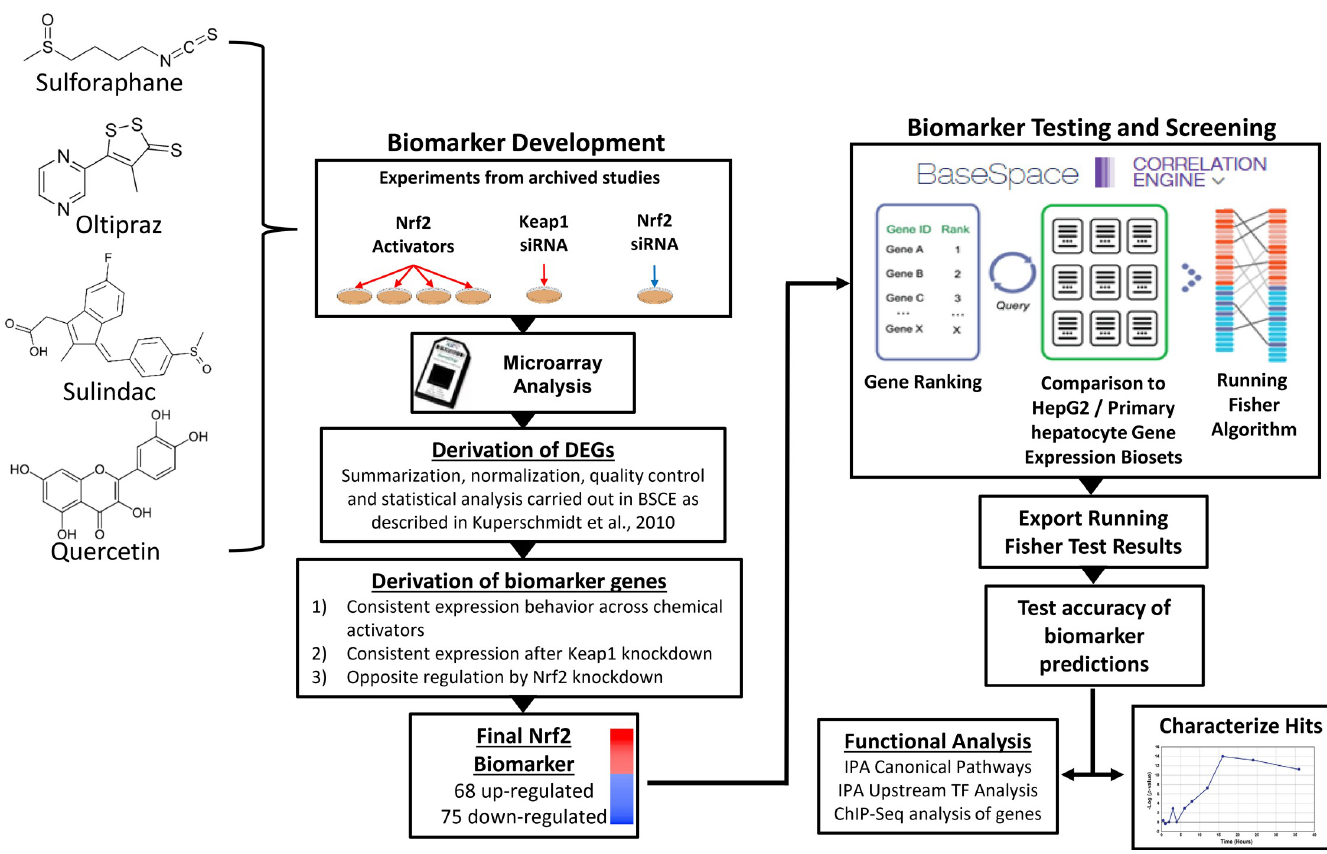
Fig 1. Biomarker construction and screening strategy. Left, NRF2 biomarker development. Differentially expressed genes (DEGs) from exposures to known NRF2 activators (sulforafan, oltipraz, sulindac, quercetin) and KEAP1 and NFE2L2 siRNA knockdown were assessed in the BSCE environment. Biomarker genes were identified as those consistently up- or down-regulated by the chemical exposures or KEAP1 knockdown and opposing regulation in NFE2L2 knockdown (further details in Results section). Ten biomarkers were initially created from biosets that varied based on chemical, time and dose of exposure, and tissue context.